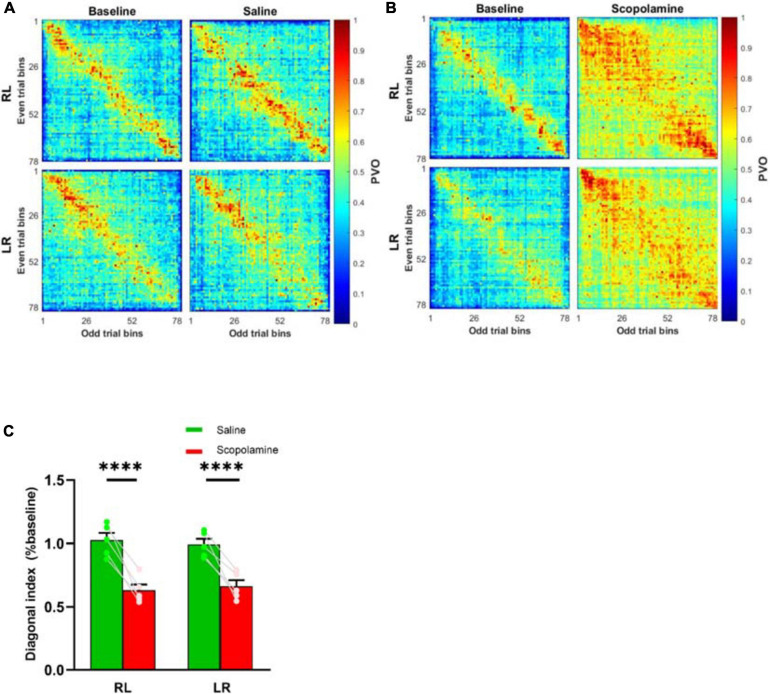
Normalised population vector overlap (PVO) of the place cells between odd trials and even trials before and after the administration of (A) saline or (B) scopolamine (1 mg/kg) in both running directions. The overlap along the diagonal in baseline indicated spiking at the same bins, and this feature disappeared after scopolamine injection. (C) The diagonal index variation measured during RL and LR running trials. ****P < 0.0001 represents the significant difference between scopolamine and saline groups.